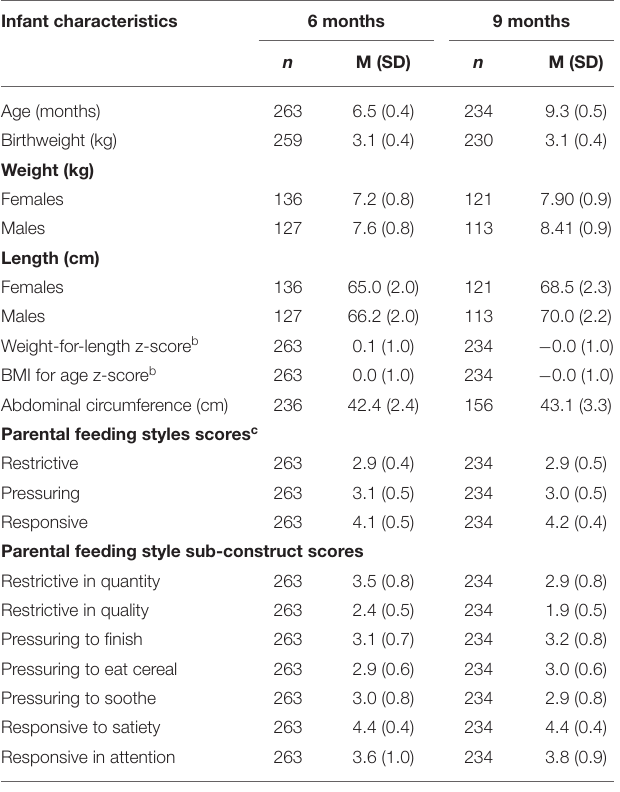
TABLE 1 | Descriptive characteristics and parental feeding styles of the study sample a